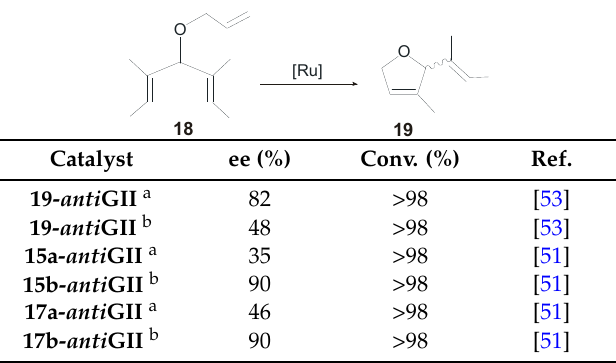
Table 5. RCM of prochiral triene 18 .